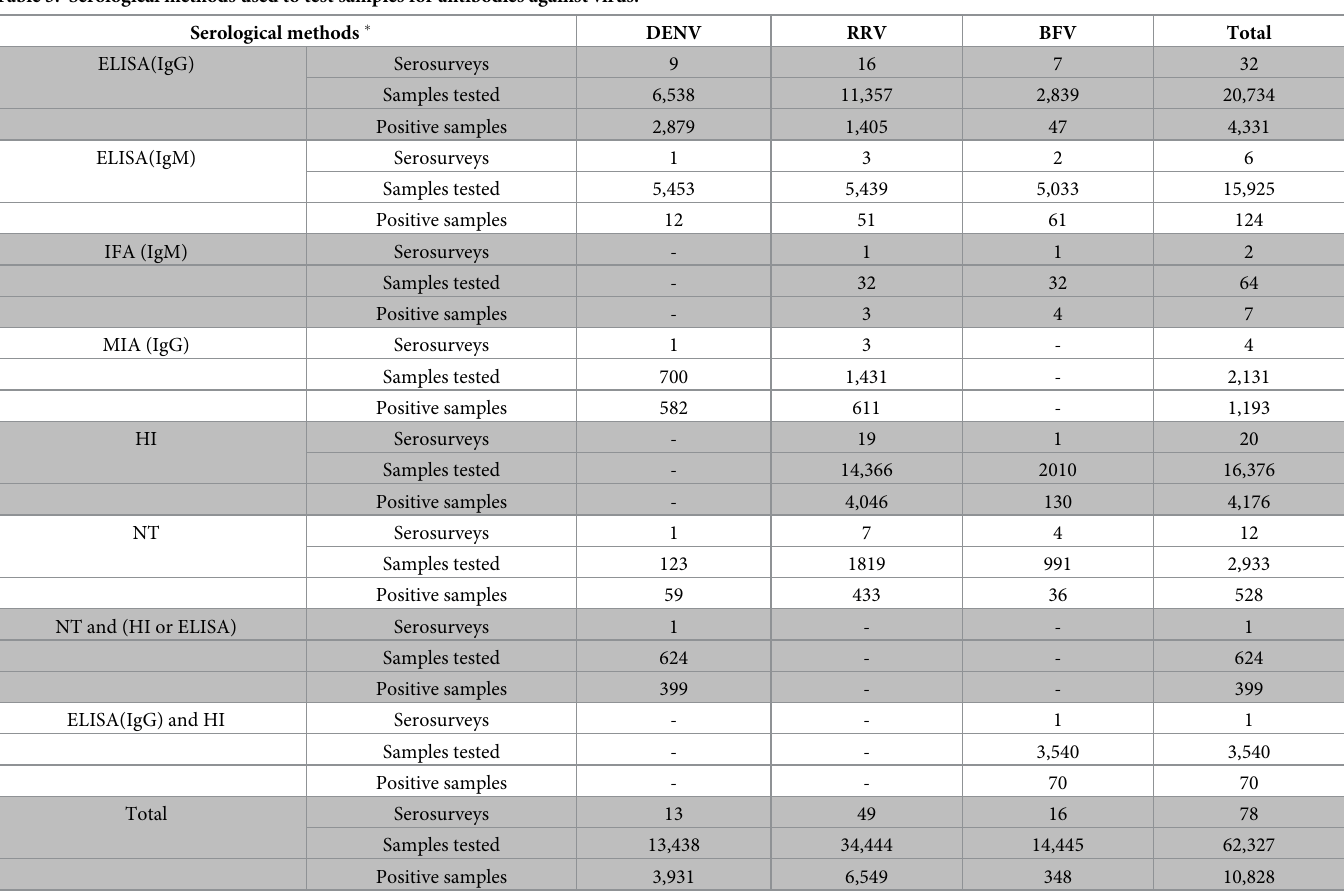
Table 3. Serological methods used to test samples for antibodies against